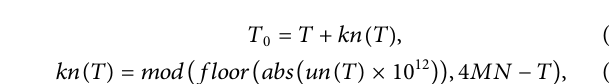
Frontiers in Physics |